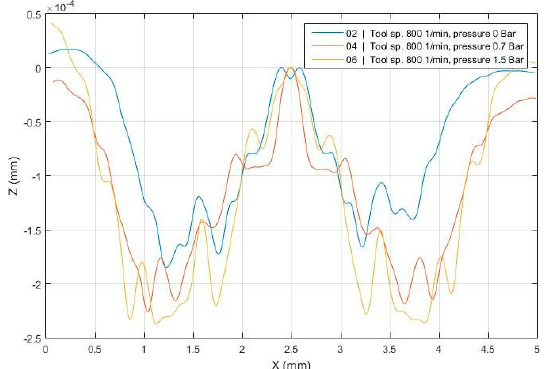
Figure 4. FEM R1O tool at 800 rpm for pressures of 0, 0.7, and 1.5 bar.